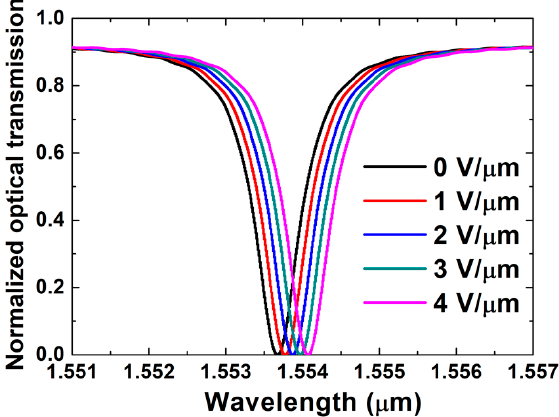
Figure 8. Transmission spectra of wavelength shift due to different electric field intensities in the Z ‐ direction. The calculations referred to the TM mode at the microring radius R = 20 μ m.